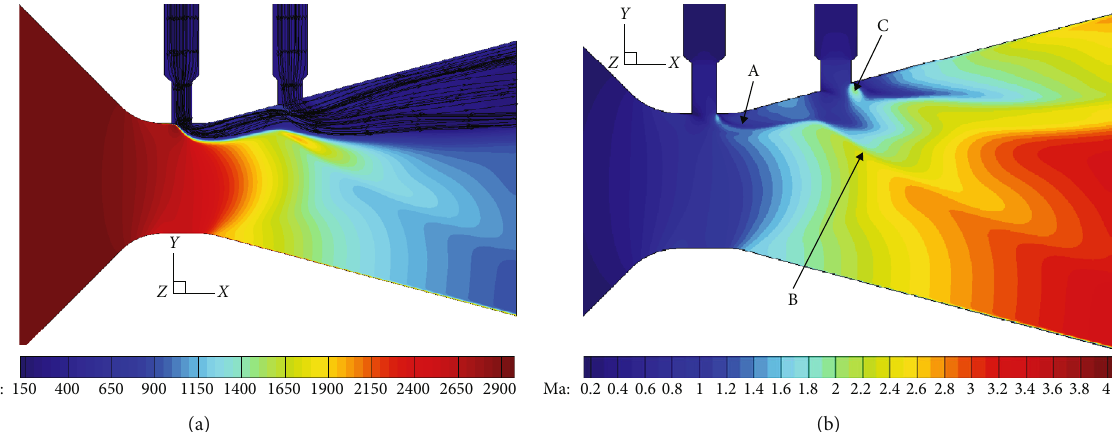
Figure 9: Contours of symmetric plane: (a) temperature contour and streamlines, z / d = 0 ; (b) Mach number contour, z / d = 0